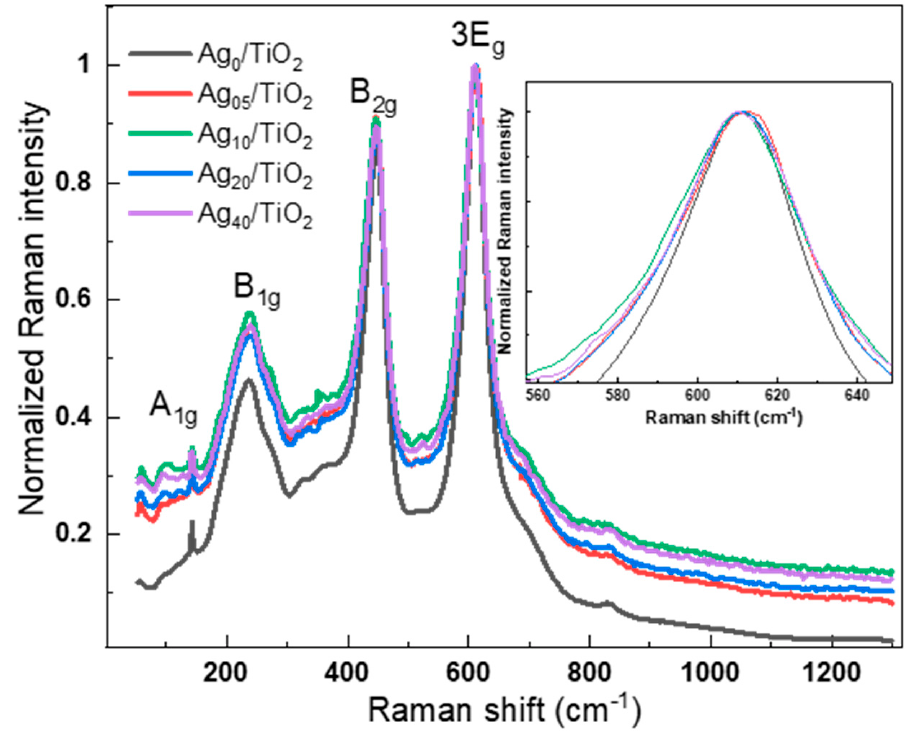
Figure 3. Raman spectrum of Ag x / TiO 2 samples. A quantitative analysis was carried out by fitting the spectra with a Lorentzian function.